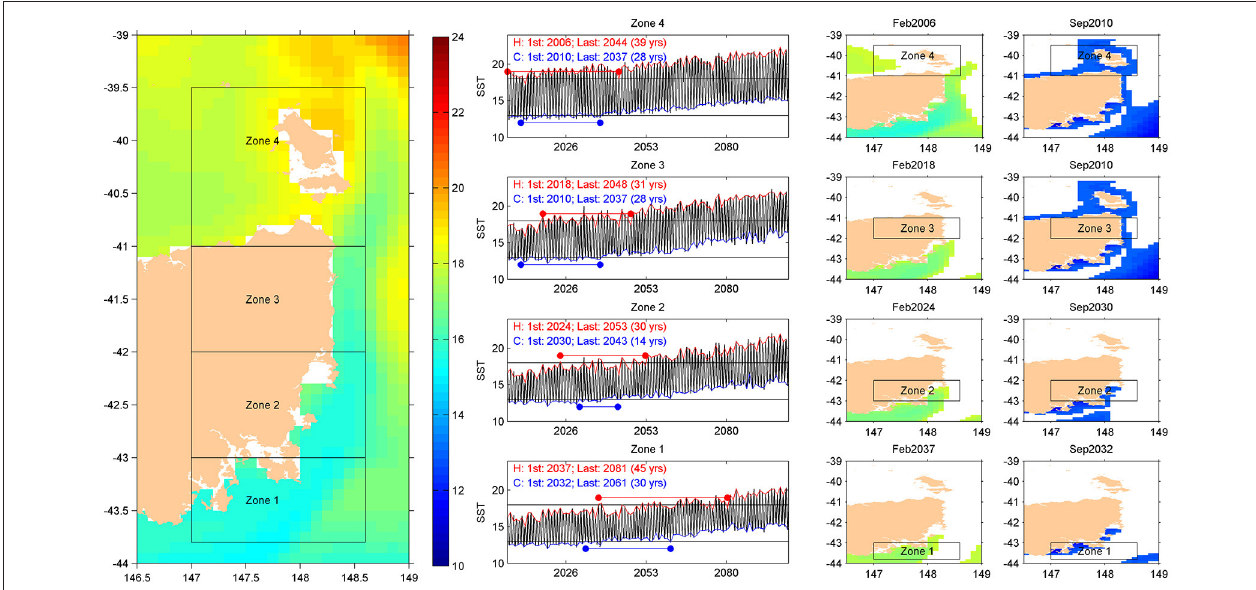
FIGURE 3 | First column: Model sea surface temperature (SST) in eastern Tasmania for February 2016. Middle column: Monthly SST time series for the period 2006-2101 (black line) for the four zones with example warm (18 ◦ C) and cold thresholds (13 ◦ C) in horizontal black lines, corresponding to maximum tolerances for a hypothetical species in summer and winter, and the average SST for February (Austral summer, red line) and September (Austral winter, blue line), typically the warmest and coldest month respectively. The first and permanent exceedance times for the summer (red dots) and winter (blue dots) are shown for each zone, and provided on each panel (red and blue text), along with the period between first and permanent exceedance. Final two columns : February and September SST maps for the year of first exceedance, showing that in each region, there are pixels where SST is below the threshold values for summer and winter (shaded). Color scale is the same in all maps. Data are from modeling experiments run by the CSIRO-downscaling